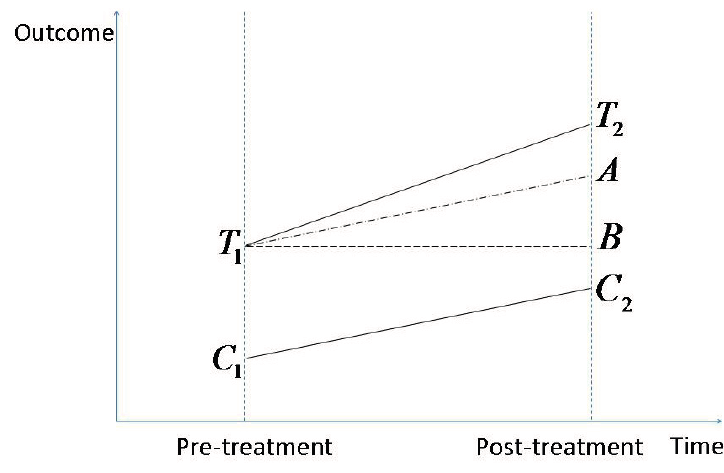
Figure 1. Graphic illustration of DID